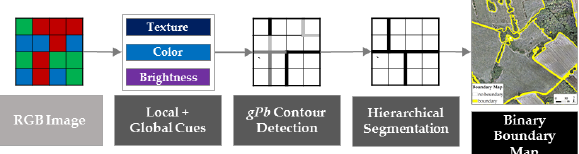
Figure 4. Processing pipeline of globalized probability of boundary (gPb) contour detection and hierarchical image segmentation resulting in a binary boundary map containing closed segment boundaries.